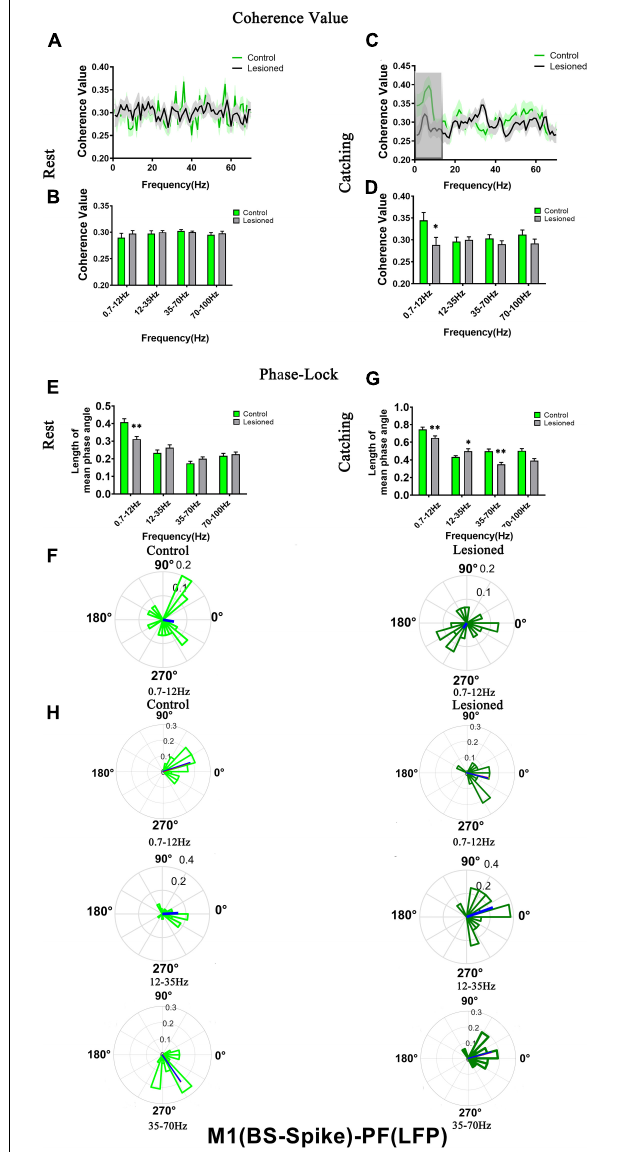
FIGURE 9 | Coherence values and phase-lock of BS with respect to PF-LFPs in the control rats and the DA-lesioned rats. Coherence values between BS ( n = 29 neurons from 16 lesioned rats, and n = 31 neurons from 14 control rats) and M1-LFP have no alterations during (A,B) rest states. During catching movements, coherence values have decreased in the lesioned group at 0.7–12 Hz compared with the control group (C,D) . During the resting epoch, phase-locking levels represented by the length of mean phase angle were significantly lower only in the range of 0.7–12 Hz in the lesioned rats compared to the control rats. Blue lines radiating from the center indicated the measure of the strength of concentration of the distribution of the mean phase angle of all recording BSs. The lower vector lengths indicated that BS neurons in the lesioned rats (dark green) were less phase-locked to PF-LFP activities at 0.7–12 Hz than those neurons in the control rats (light green) (E,F) . During catching movements, the length of mean phase angle was significantly lower in the ranges of 0.7–12 and 35–70 Hz in the lesioned rats (dark green) compared to the control rats (light green) but was significantly increased at 12–35 Hz (G,H) . Data are expressed as the mean ± SEMs ( ∗ p < 0.05, ∗∗ p <